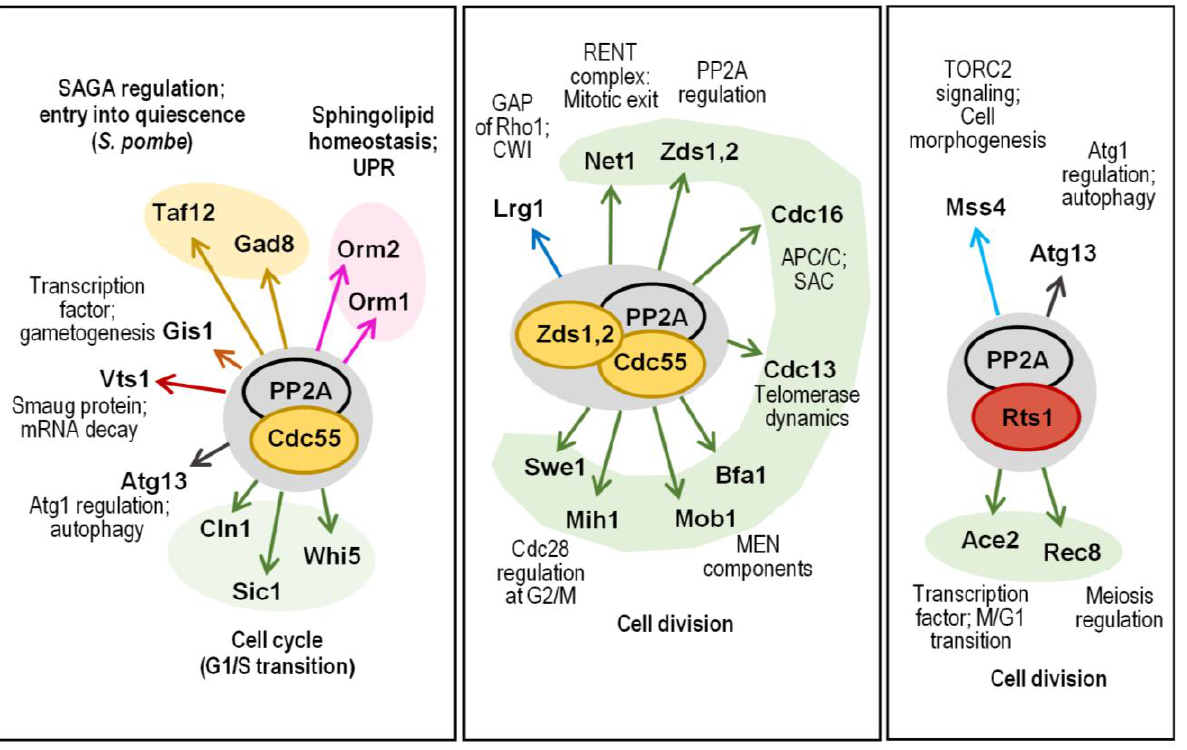
FIGURE 5: Multiple roles of PP2A in cellular functions. The cartoon shows the different combinations of PP2Ac with its regulatory subu- nits, and their role in different cell functions is depicted. Relevant substrates are also annotated and grouped with color codes denoting specific